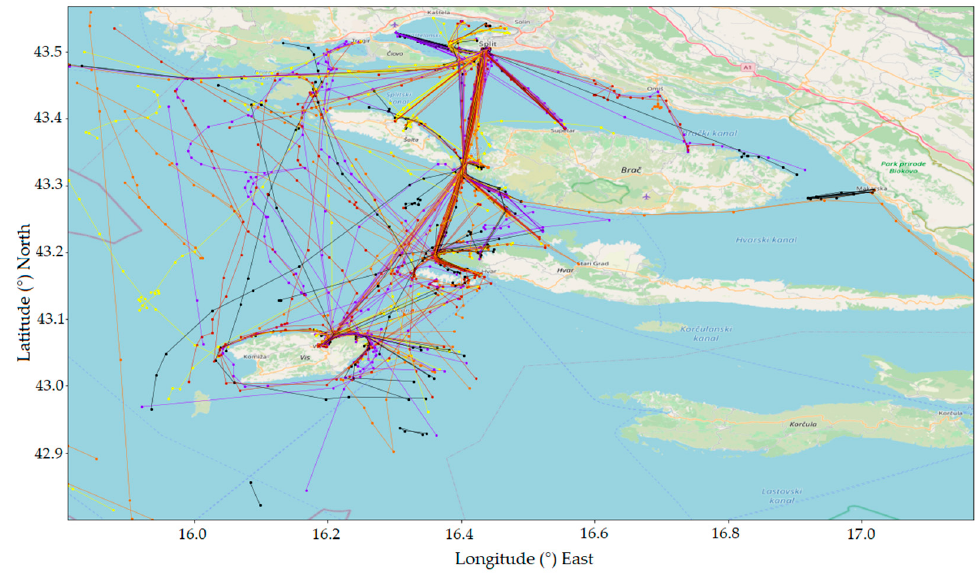
Figure 7. D ensity map based on processed AIS data. Figure 7. Density map based on processed AIS data.